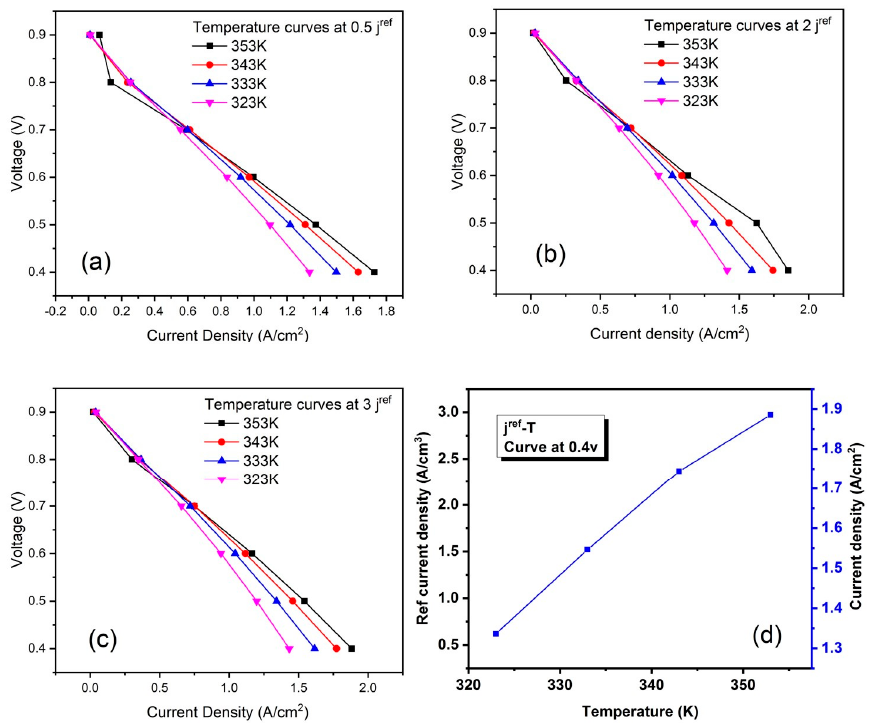
Figure 9. Effects of temperature on RCD at ( a ) 0.5; ( b ) 2; ( c ) 3; and ( d ) Polarization curve between RCD and temperature at 0.4 v.